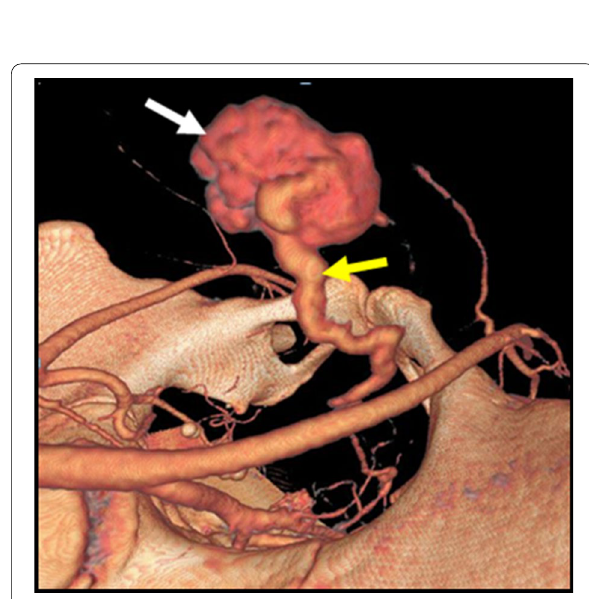
Fig. 3 3D volume-rendered CT image shows feeding vessels (yellow arrow) from the internal iliac artery to the highly vascular urinary bladder wall lesion (white